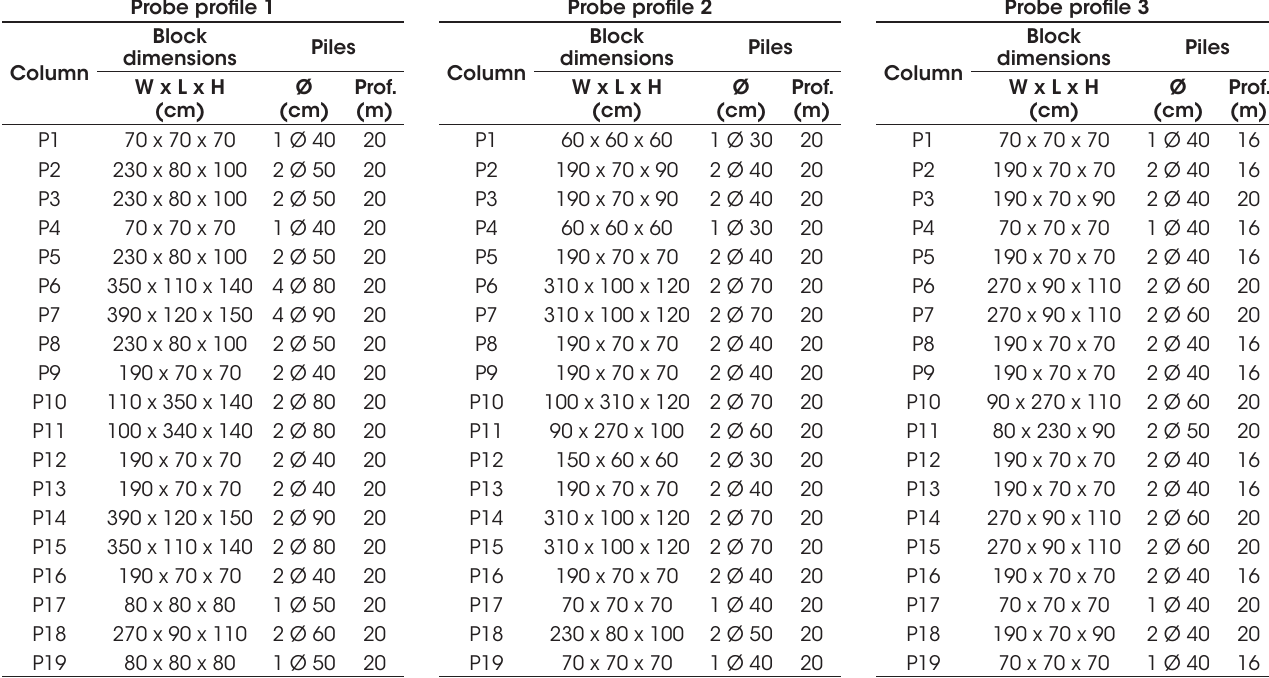
Data of the foundations of the 4-floor